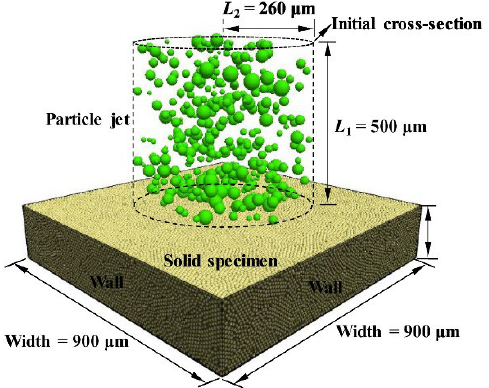
Figure 33. Model setup for the abrasive particle jet against the solid specimen in the DEM simulation [185].